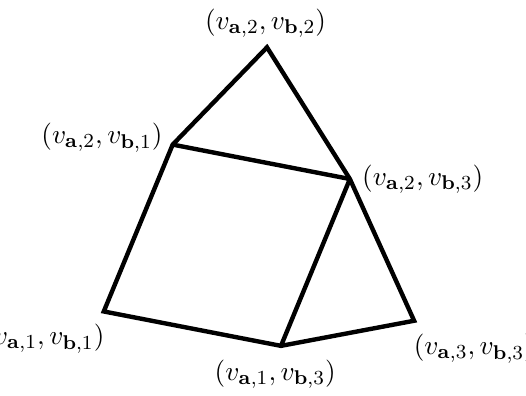
. Γ α and Γ α for a 1 α 2 2 α 3 1 α 3